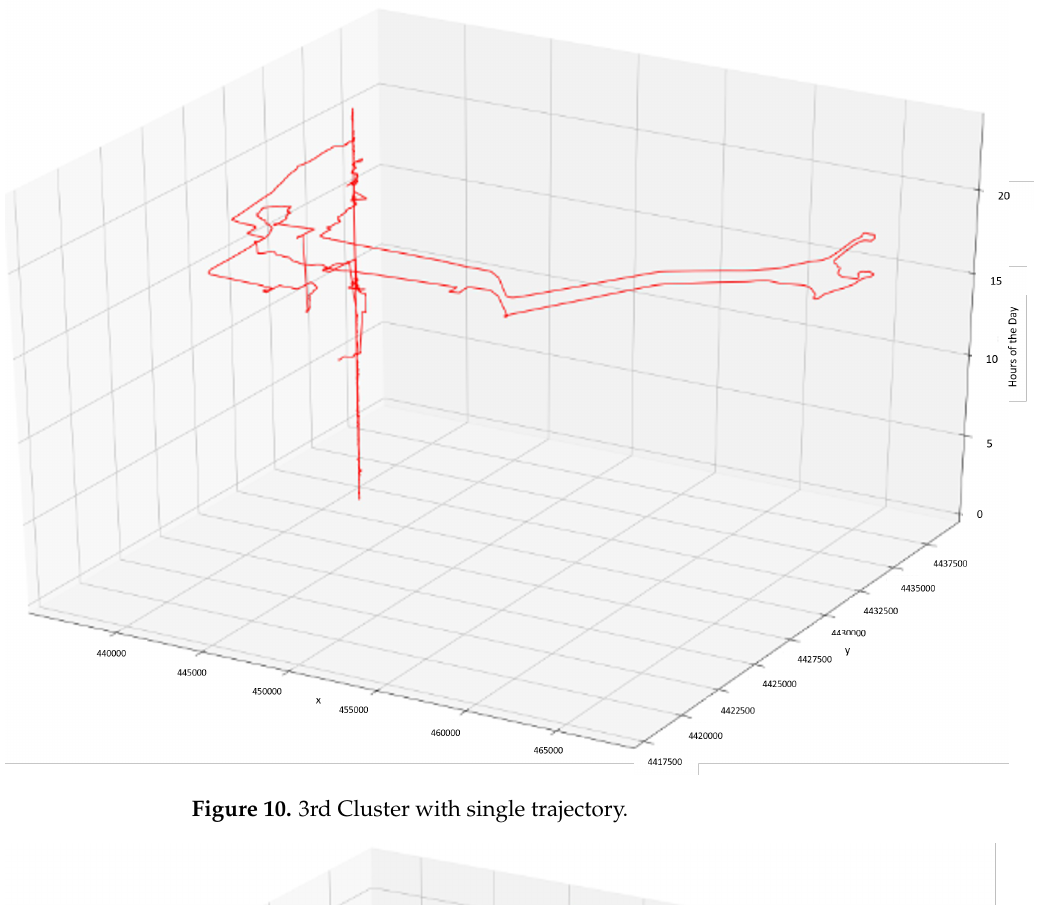
Figure 10. 3rd Cluster with single trajectory.